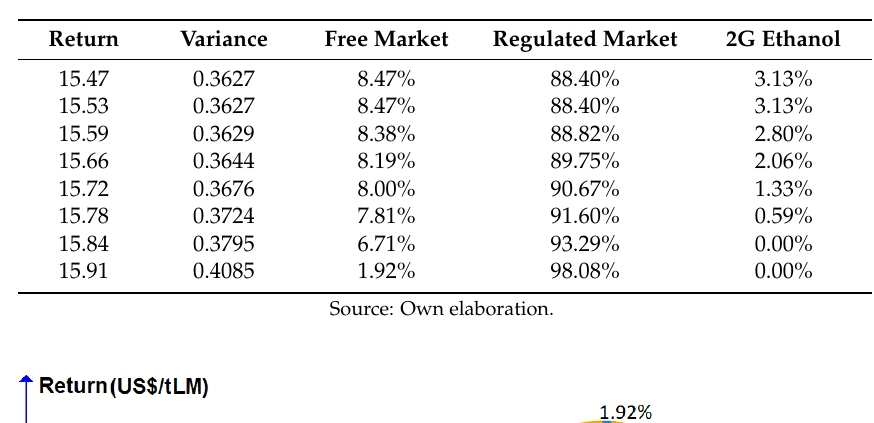
Table 7. Results of the mean-variance model for scenario 2.